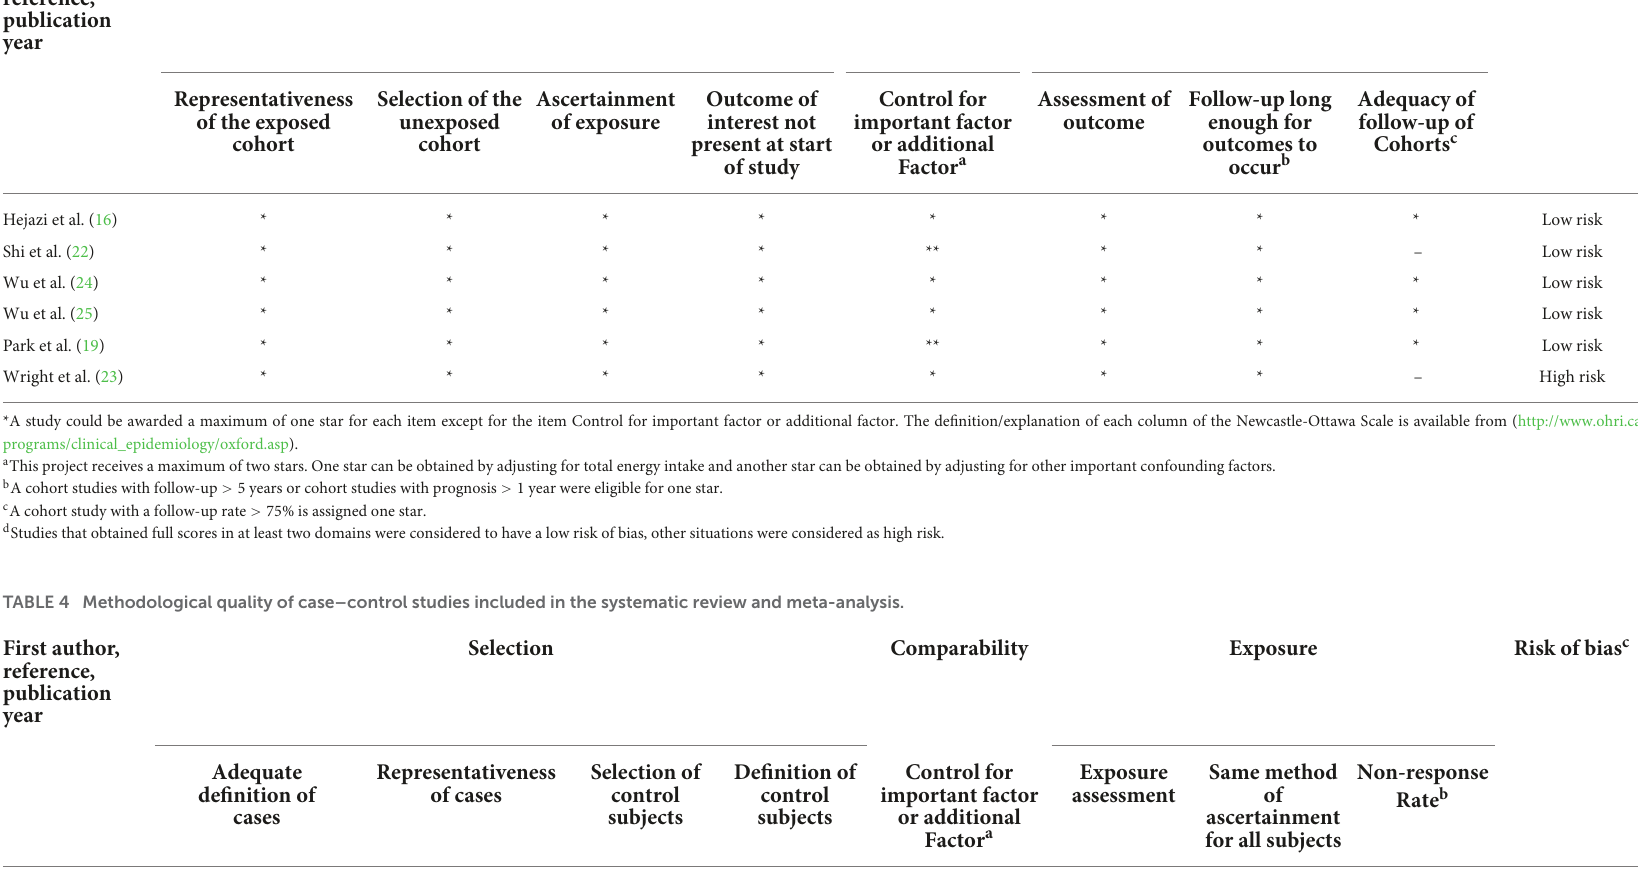
TABLE 3 Methodological quality of cohort studies included in the systematic review and meta-analysis.